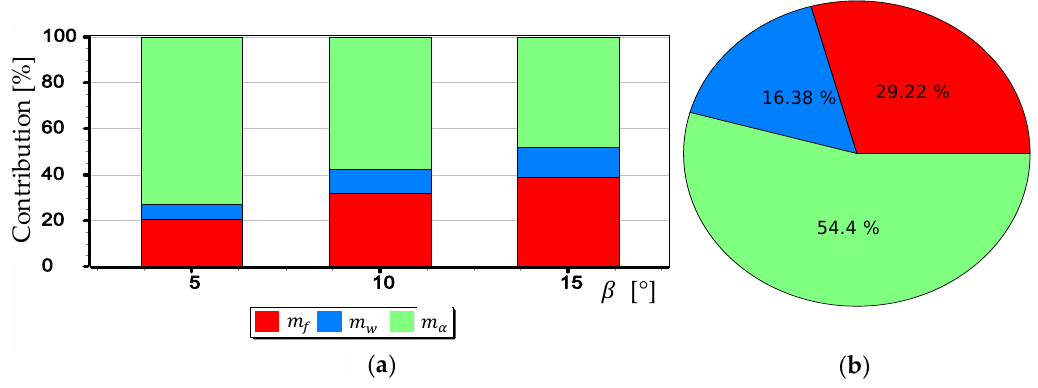
Figure 30. Percentage contribution for DIJ FC550RAW camera: ( a ) Calculated for β equals 5°, 10° and 15° ; ( b ) Calculated as a mean value.